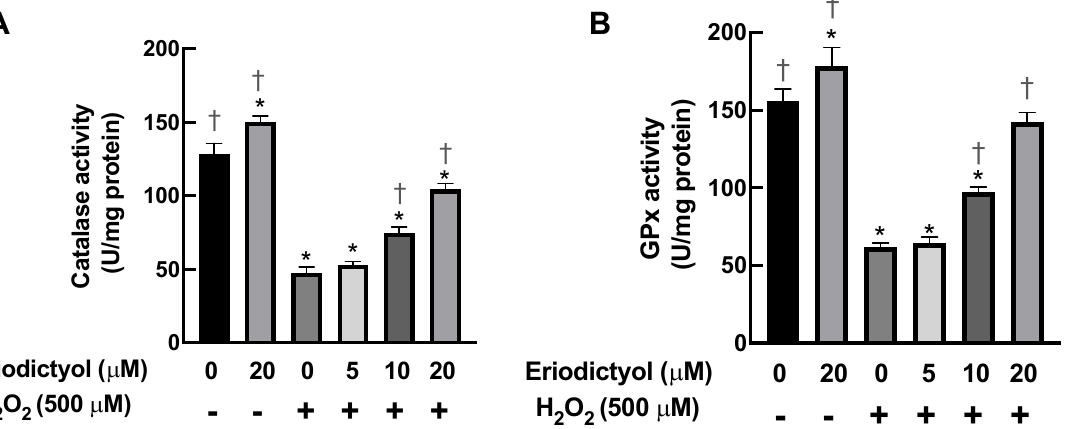
Figure 6. Eriodictyol enhances the activities of CAT and GPx. ( A , B ) Eriodictyol pretreatment (10–20 µ M; 24 h) promoted the activities of H 2 O 2 -detoxifying enzymes CAT and GPx in BJ cells following H 2 O 2 exposure (500 µ M; 1 h) in a concentration-dependent manner. DMSO (0.5%) was used as a vehicle control. Enzymatic activities were determined immediately after the treatments ( n = 3; each biological replicate consisted of three independent wells; mean ± SEM). * p < 0.05 versus vehicle controls; † p < 0.05 versus H 2 O 2 -treated cells.